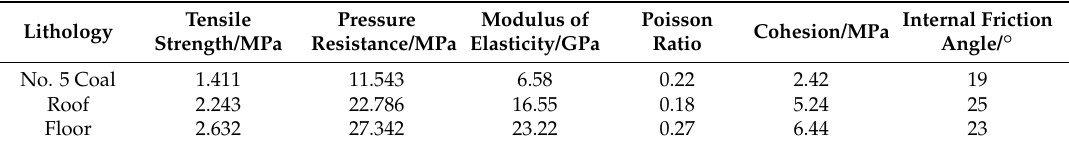
Table 1. Mechanical properties of coal and rocks.